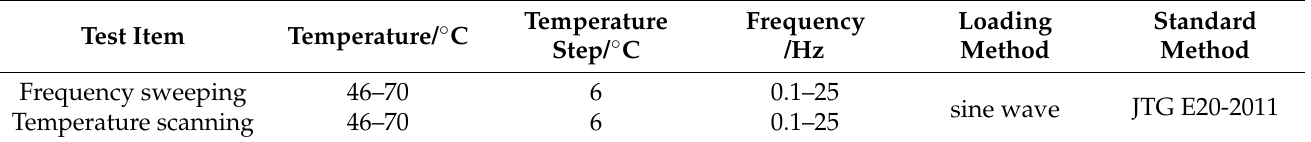
Table 3. Dynamic shear rheological test scheme.